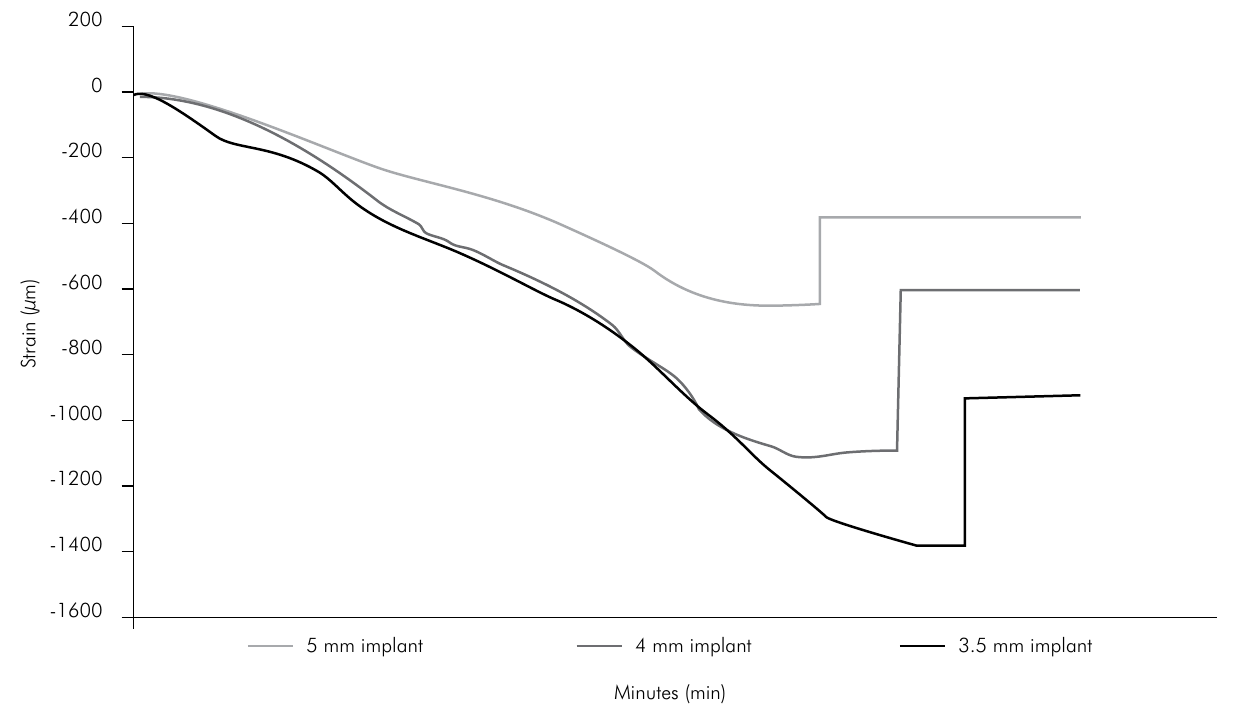
Figure 4. Strain (µS) curve obtained for the three different implant diameters according to the loading 0 - 1500 - 0